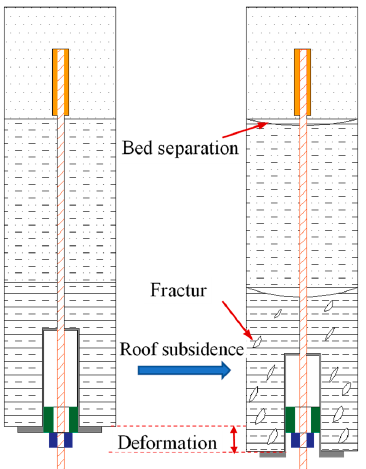
Figure 5. Working principle of the CRLDA cable.